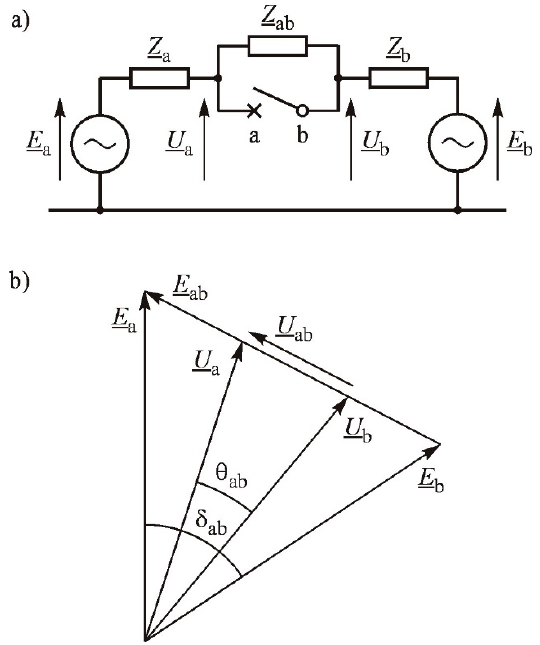
Figure 3. Model for determining the initial switching current; ( a ) substitute scheme, ( b ) phasor’s diagram.